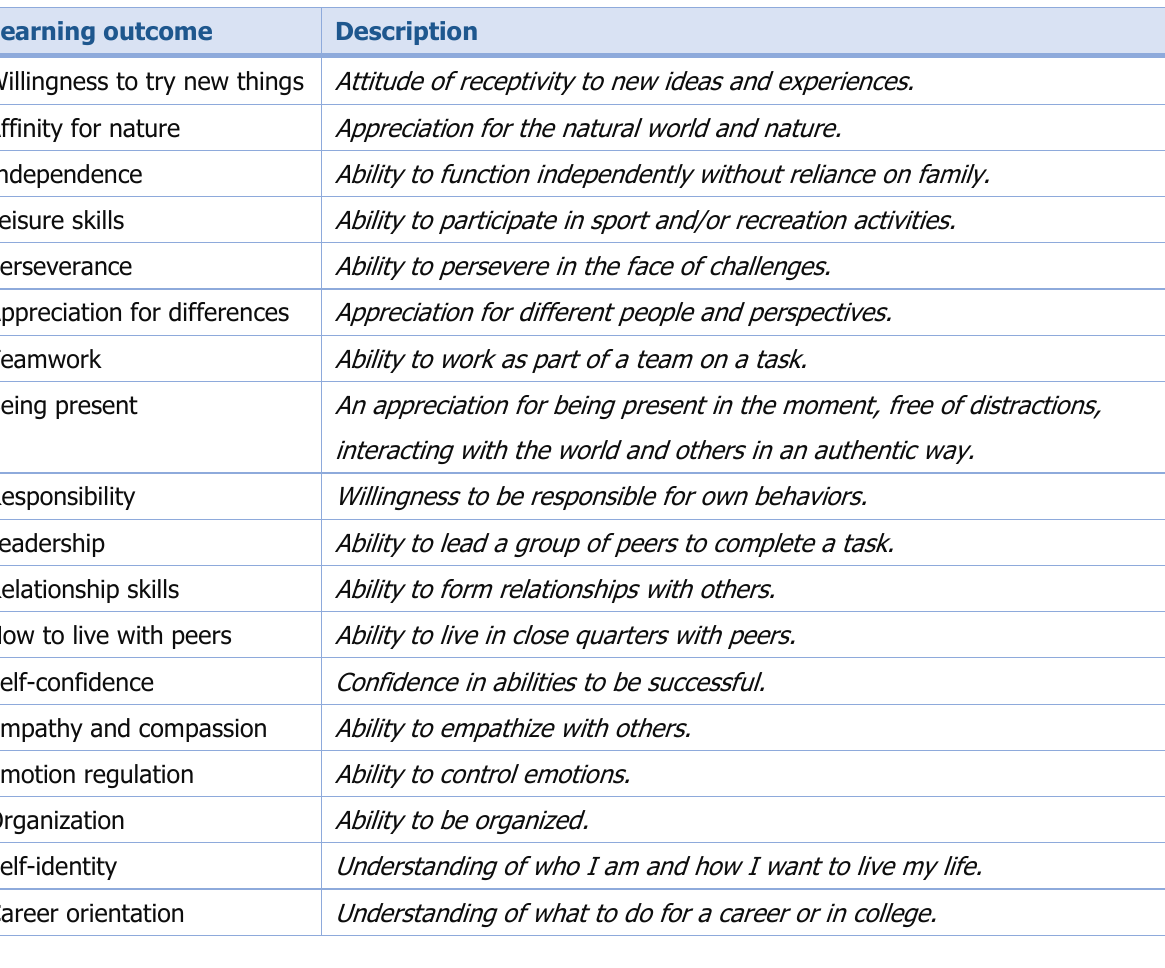
Table 1. Descriptions of Learning Outcomes Identified Through Qualitative Coding of